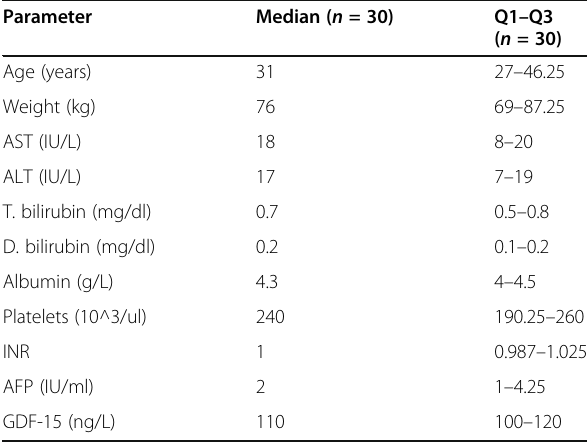
Table 1 Descriptive statistics of the different studied